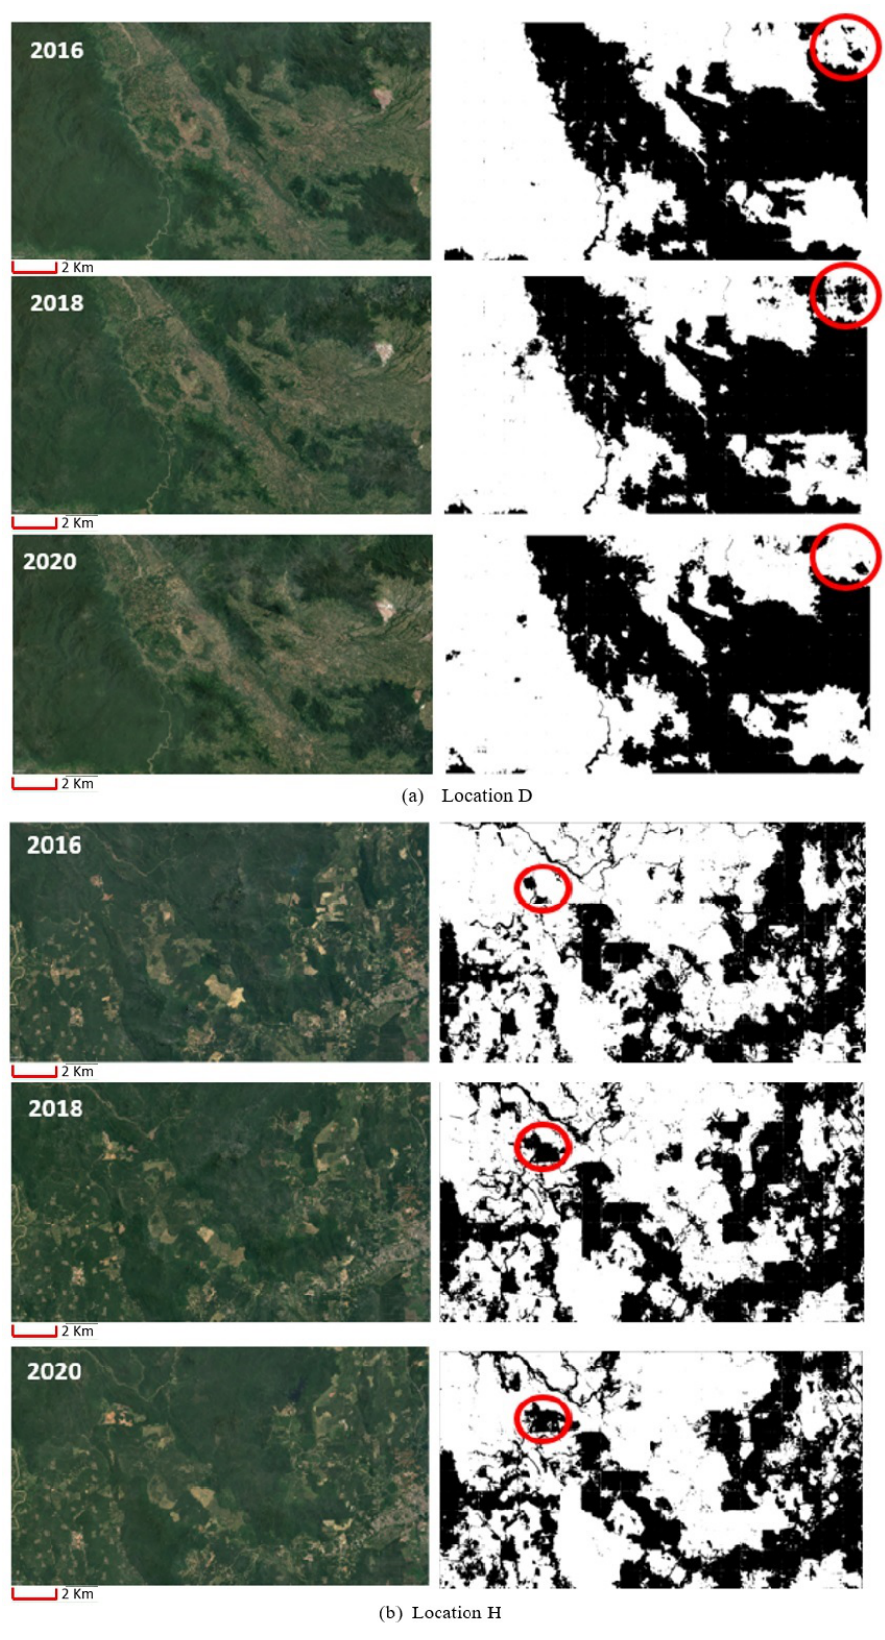
Figure 8. Predicted output images at ( a , b ) from 2016 to